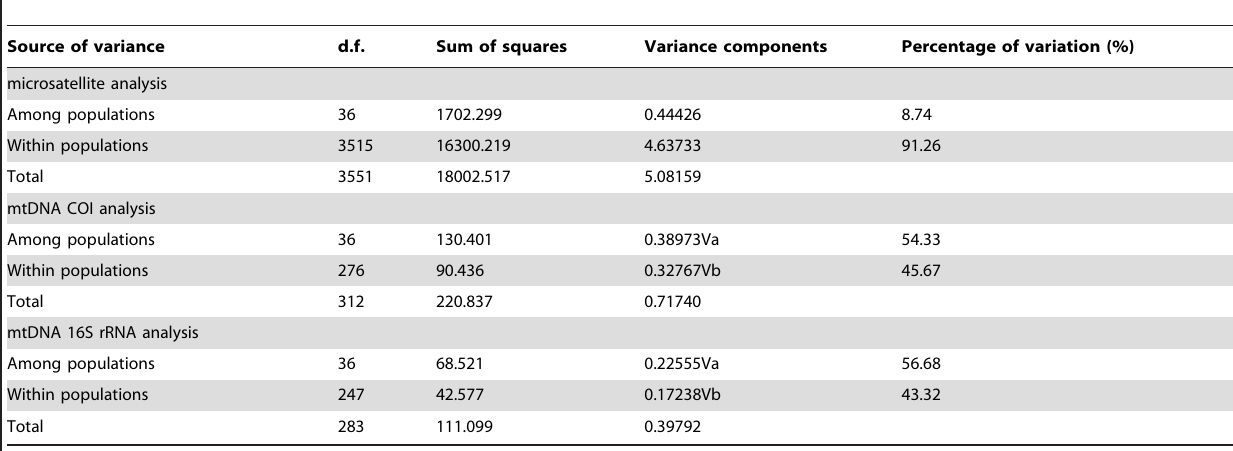
Table 1. Analysis of molecular variance within and among P. clarkii populations by microsatellite, mtDNA COI and 16S rRNA